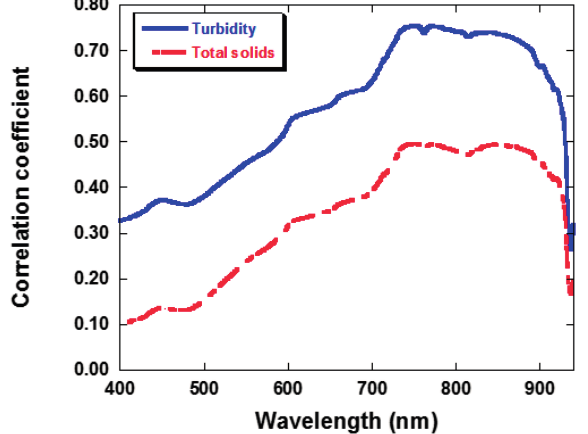
Figure 4. Examples of the change in the Pearson’s product moment correlation coefficient with wavelength of water quality